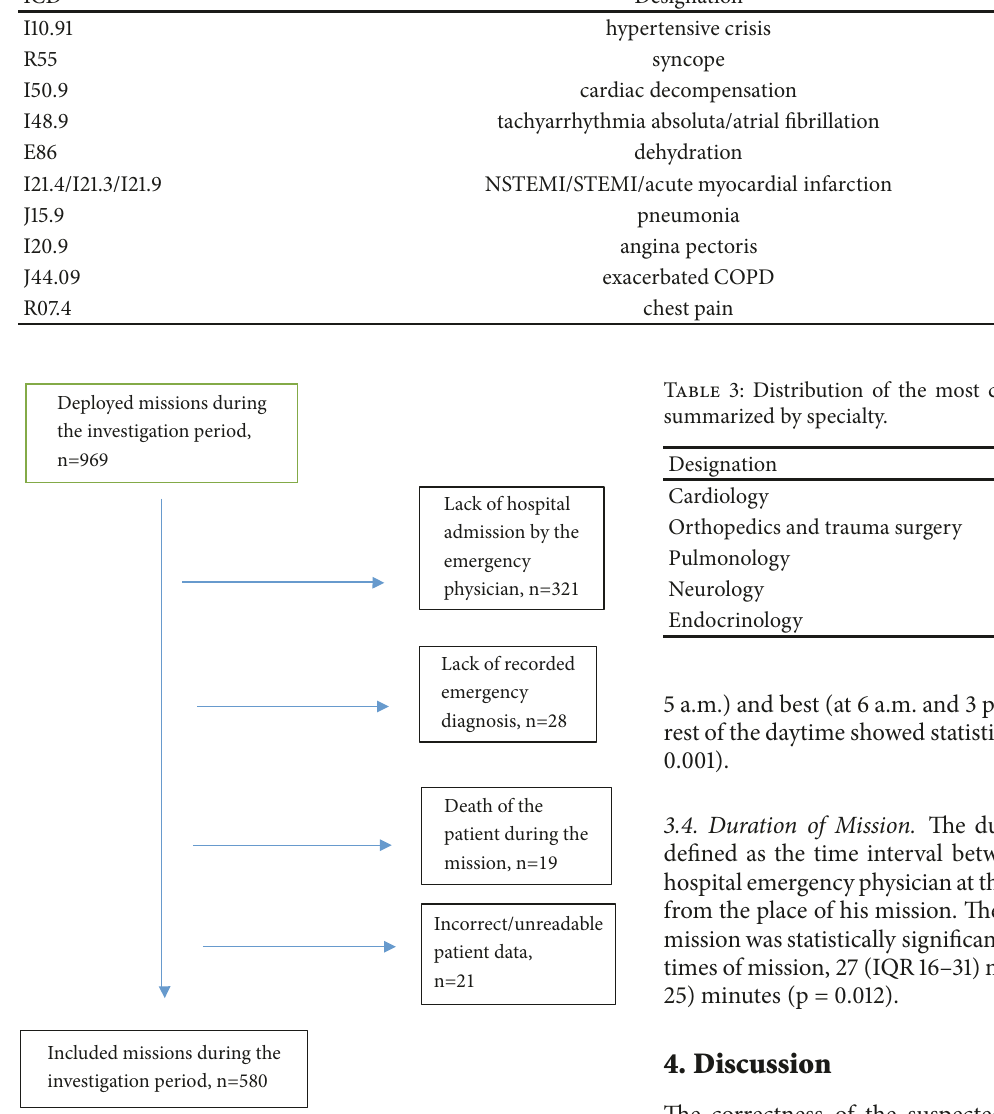
Figure 1: Inclusion chart.